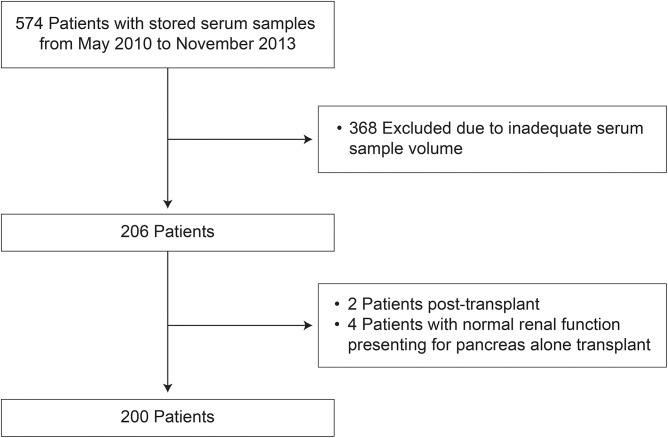
Flowchart of patients screened and included in the study.